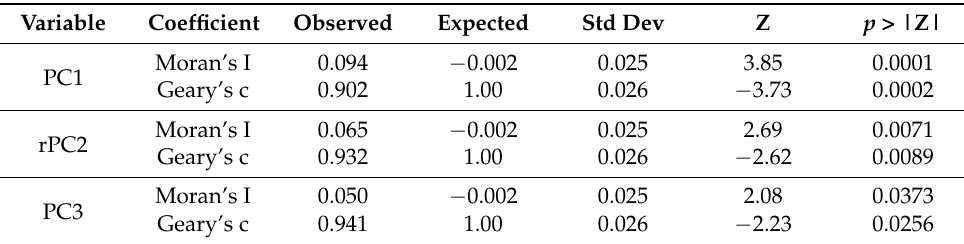
Table 4. Tests of spatial autocorrelation of the three